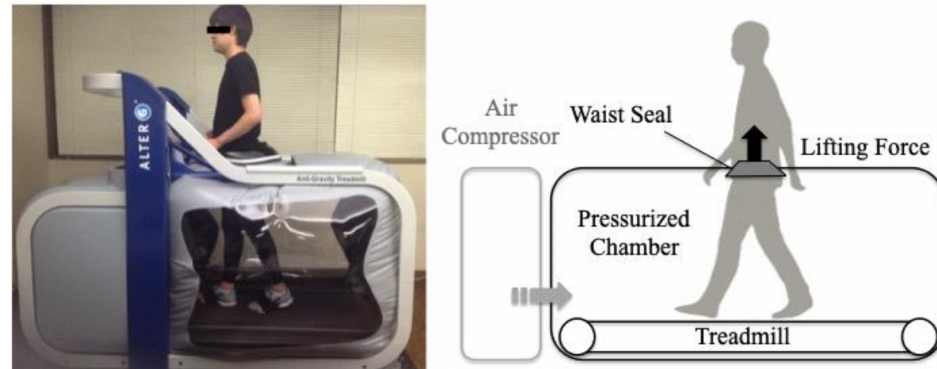
Figure 2. Lower body positive pressure (LBPP) treadmill used in the present study. In this treadmill, an air-compressor inflated the chamber to create a lifting force on the lower body by positive pressure. Subsequently, this treadmill could provide precise BWS during gait. Participants walked on this treadmill while wearing seven sensor units under the three BWS